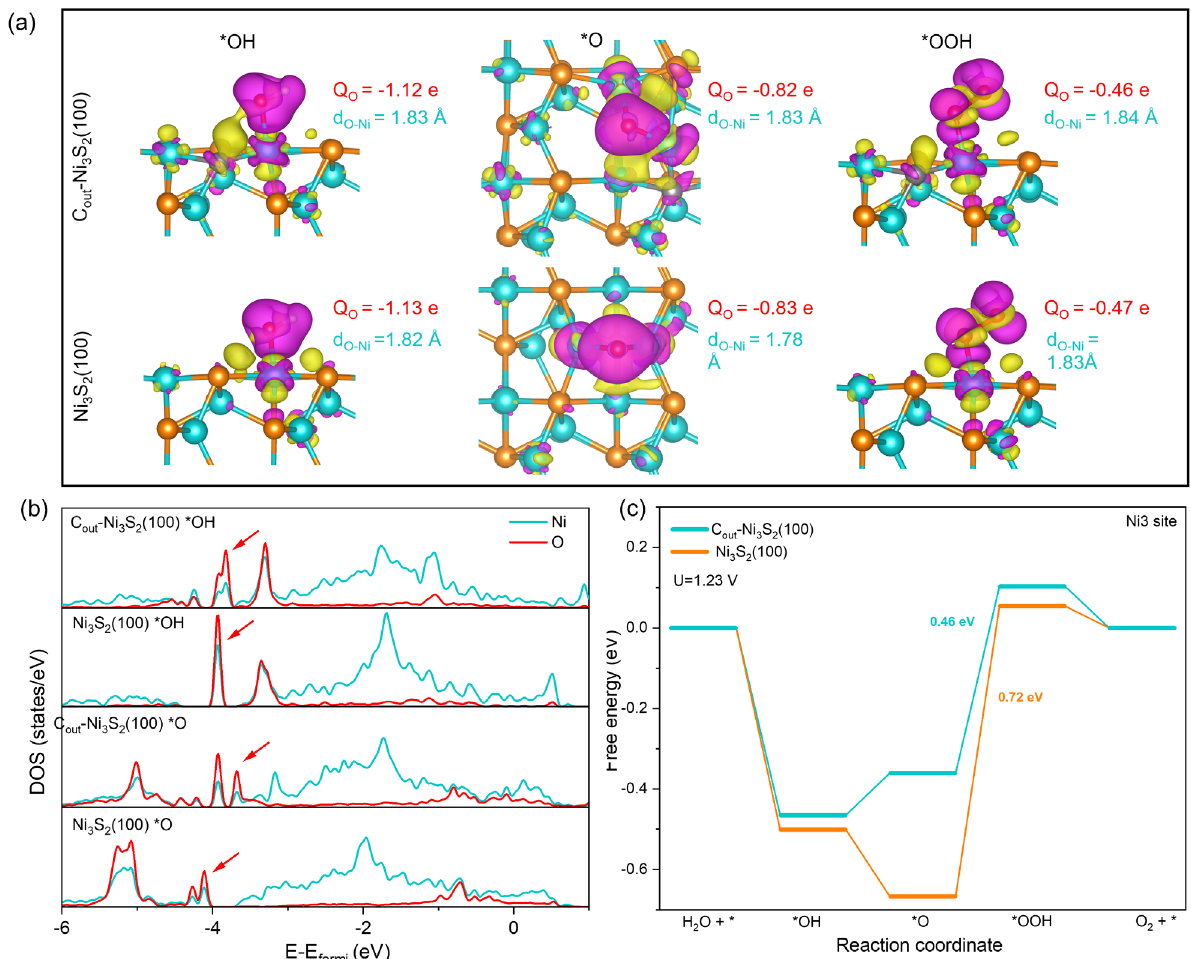
Figure 5. ( a ) The Bader charge of O (Q Ni ), bond legth of O-Ni (d O-Ni ), and the charge density difference of OER intermediates adsorption on Ni3 site of C out -Ni 3 S 2 (100) and Ni site of Ni 3 S 2 (100) (The purple part represents charge accumulation, while yellow part represents charge depletion. The isosurface level is set as 0.002 eV Å − 3 ). ( b ) The density of states (DOS) for OH and O adsorption on the Ni3 site of C out -Ni 3 S 2 (100) and Ni site of Ni 3 S 2 (100). ( c ) The OER free energy diagram of Ni3 site of C out -Ni 3 S 2 (100) and Ni site of Ni 3 S 2 (100). The weakened OER intermediate adsorption on the Ni3 site of C out -Ni 3 S 2 (100) mainly results from an electronic structure alerted by C dopants. C dopant makes the charge of Ni3 site more positive and the d band center of Ni3 site negatively shift when compared with those of the Ni site on Ni 3 S 2 (100) (Table S5). Consequently, this decreases the charge transferred from Ni to O and weakens the O-Ni bonds. Moreover, the surface structure also contributes to weakening the O adsorption. Specifically, the disturbance on local structure caused by C out makes the Ni3-Ni4 distance (4.68 Å) longer than the pristine Ni3-Ni4 distance (4.07 Å), which leads O to prefer bonding with Ni3 and the Ni7 atoms rather than Ni4 atom. Due to the more saturated coordination and lower position in the Z direction of the Ni4 atom, O forms a longer and weaker Ni-O bond with the Ni atom. Thus, the special surface geometric and electronic structure induced by C doping can weaken OER intermediates’ (especially O) adsorption on the Ni3 site of C out -Ni 3 S 2 (100) and reduce the ∆ G of the PDS ( ∆ G ∗ OOH − ∆ G ∗ O ), consequently yielding a better OER activity with η as low as 0.46 V (Figure